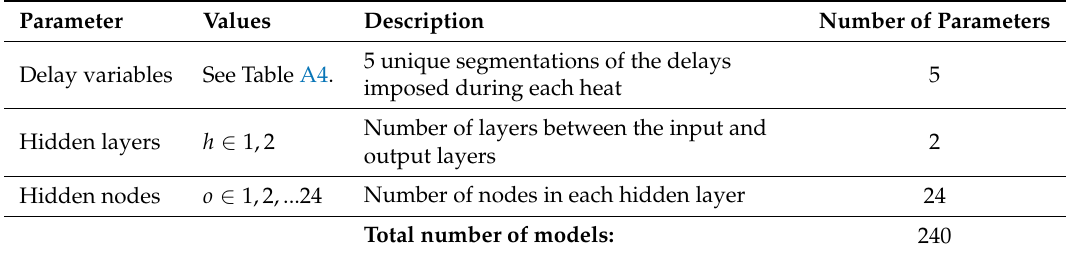
Table A1. The parameters that were varied and the resulting total number of models used in the grid-search.